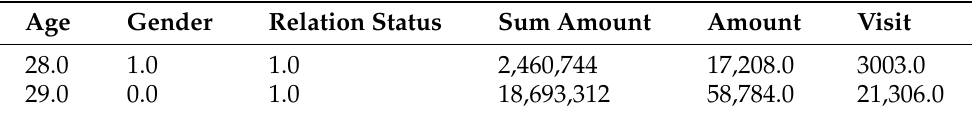
Table 7. Need based Package for Category C.